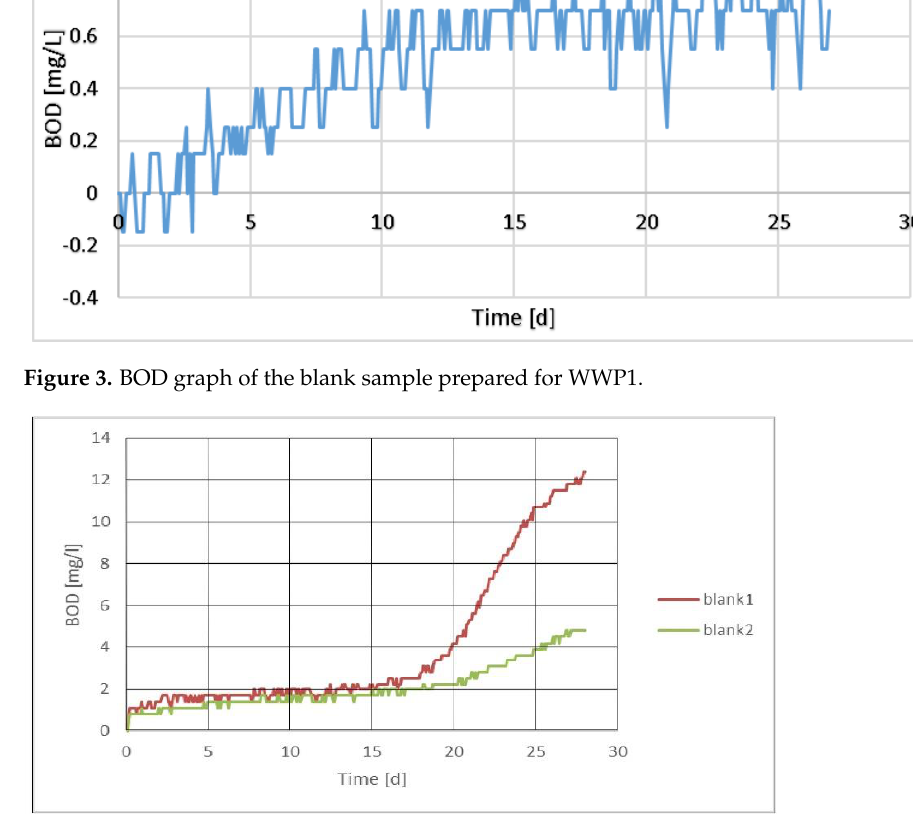
Figure 4. BOD graph of the blank sample prepared for WWP2.